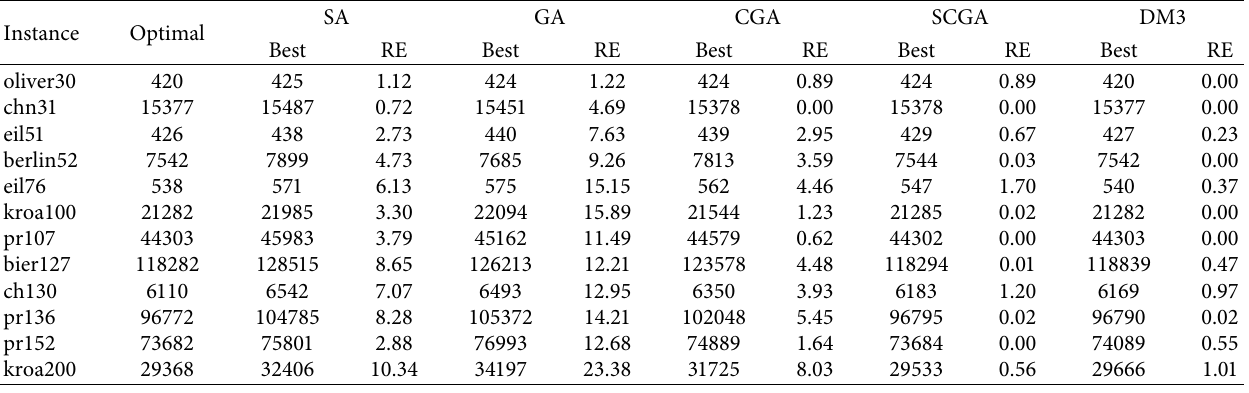
Table 1: Results found by DM3 and other metaheuristics applied on TSP-LIB instances.